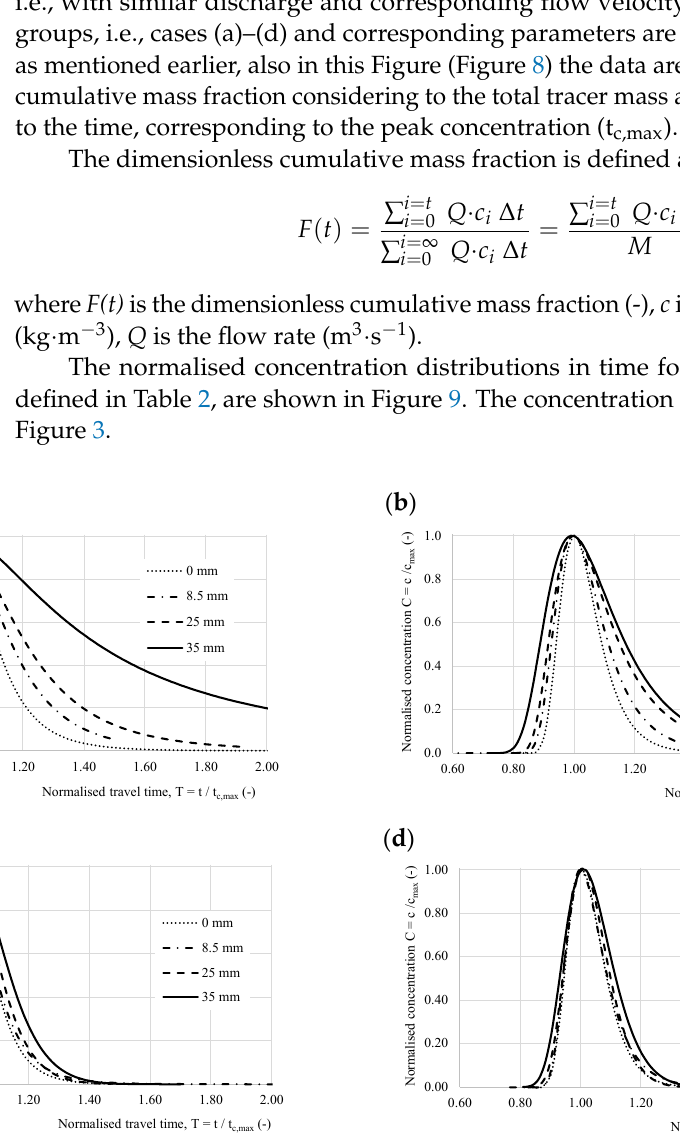
Figure 9. Results of tracer experiments—normalised concentration distributions in time. The particular image tagging ( a – d ) corresponds with the experiment groups in Table 2.